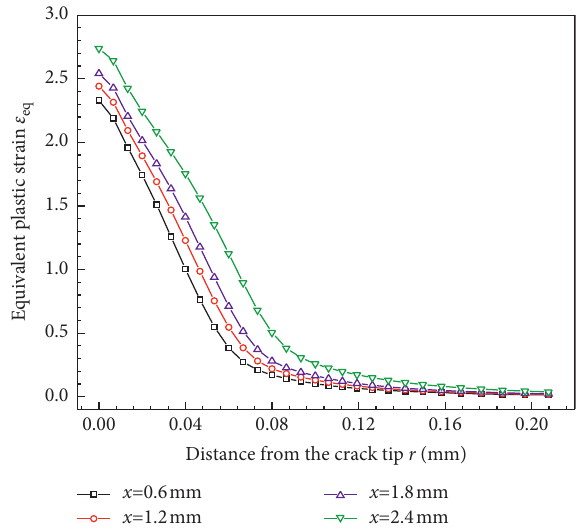
Figure 15: Equivalent plastic strain curves at the front of FB line crack tip.